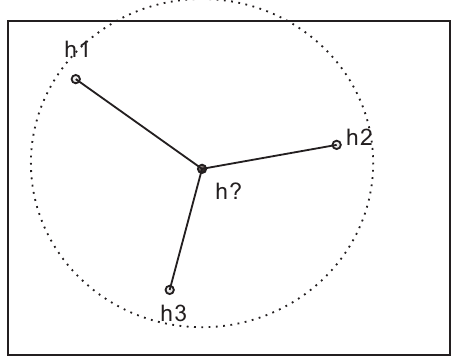
Figure 1. Definition of Pattern for groundwater level in multiple-point geostatistics.